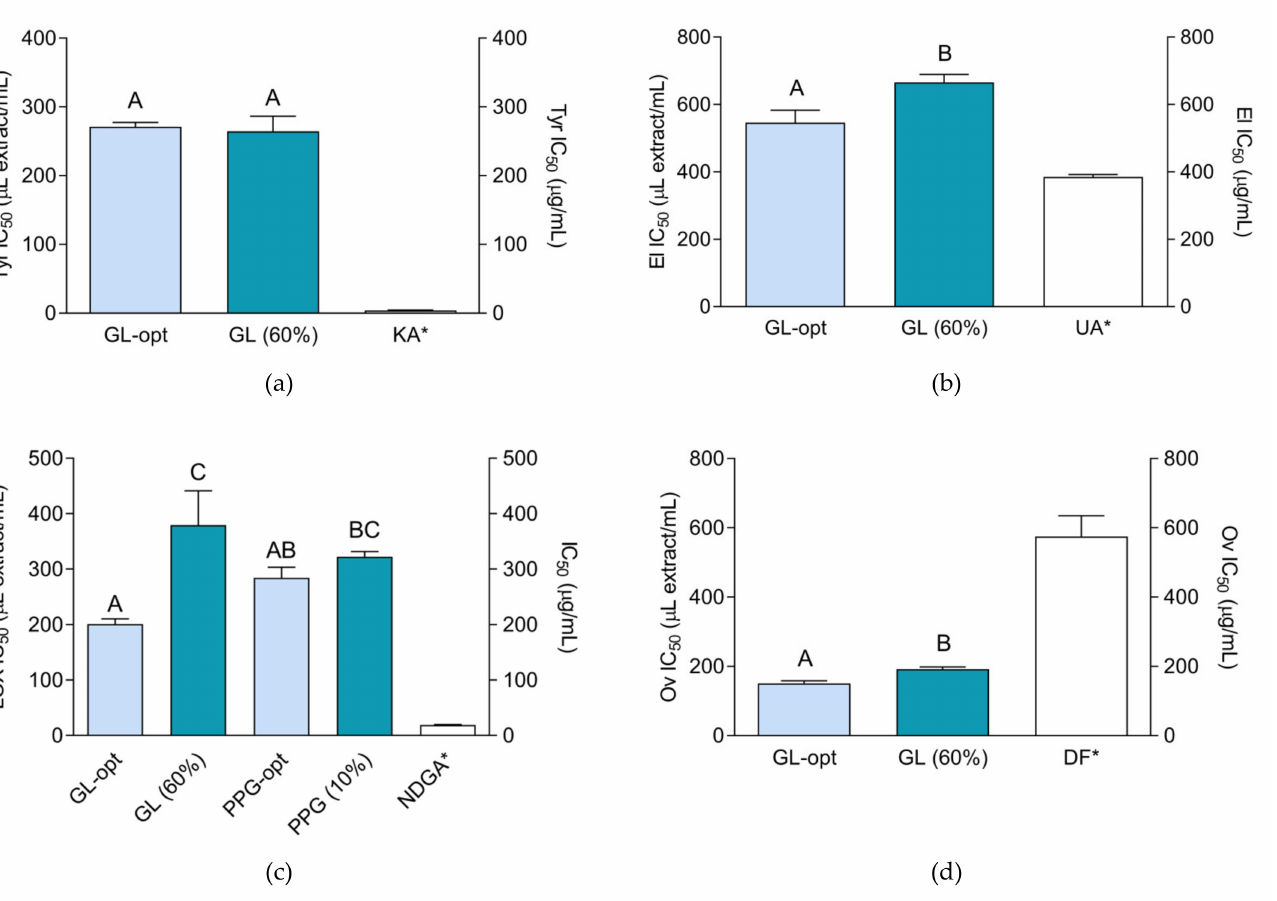
Figure 3. Cosmeceutical activity of the extracts, extraction solvents (60% glycerol-GL(60%)) and positive controls: kojic acid (KA), ursolic acid (UA), nordihydroguaiaretic acid (NDGA) and diclofenac (DF): ( a ) tyrosinase-inhibiting activity (Tyr); ( b ) elastase-inhibiting activity (El); ( c ) lipoxigenase-inhibiting activity (LOX); ( d ) ovalbumin coagulation-inhibiting activity (Ov). The activity is expressed as IC 50 value. Asterisk (*) indicates that the IC 50 unit is placed on the right y -axis. Different uppercase letters indicate statistically significant difference ( p <